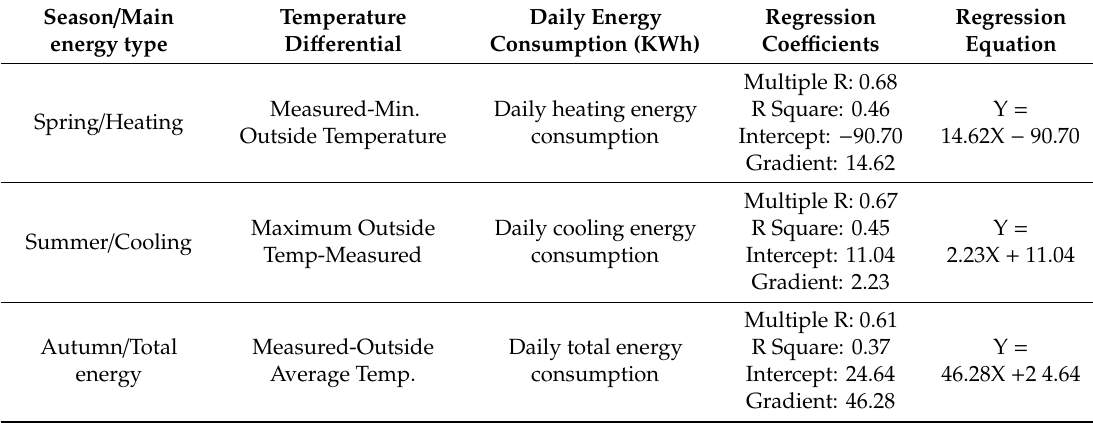
Table A7. Outcomes of regression analyses of each energy consumption